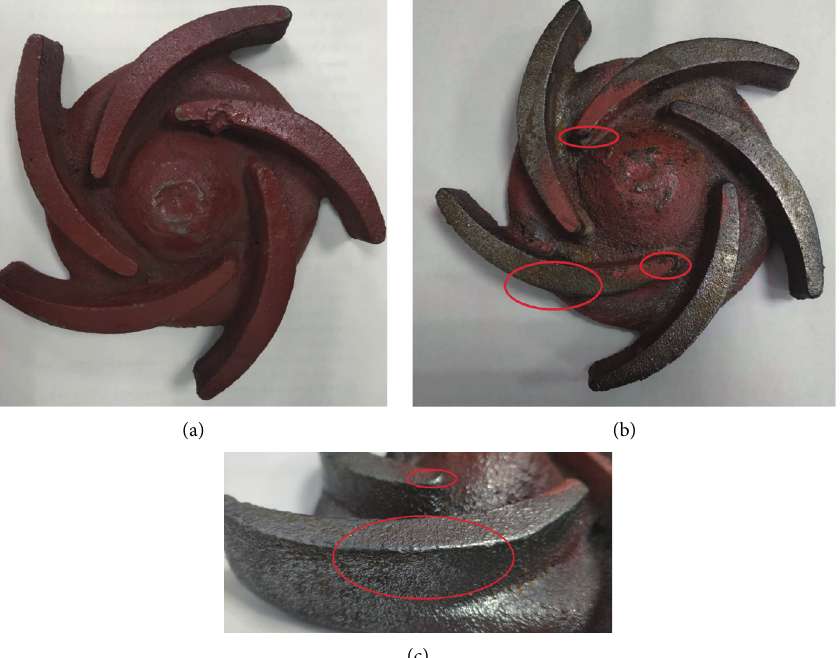
Figure 18: Wear numerical simulation and experimental comparison of the impeller. (a) Impeller before experiment; (b) experimental wear of impeller; (c) experimental wear of pressure